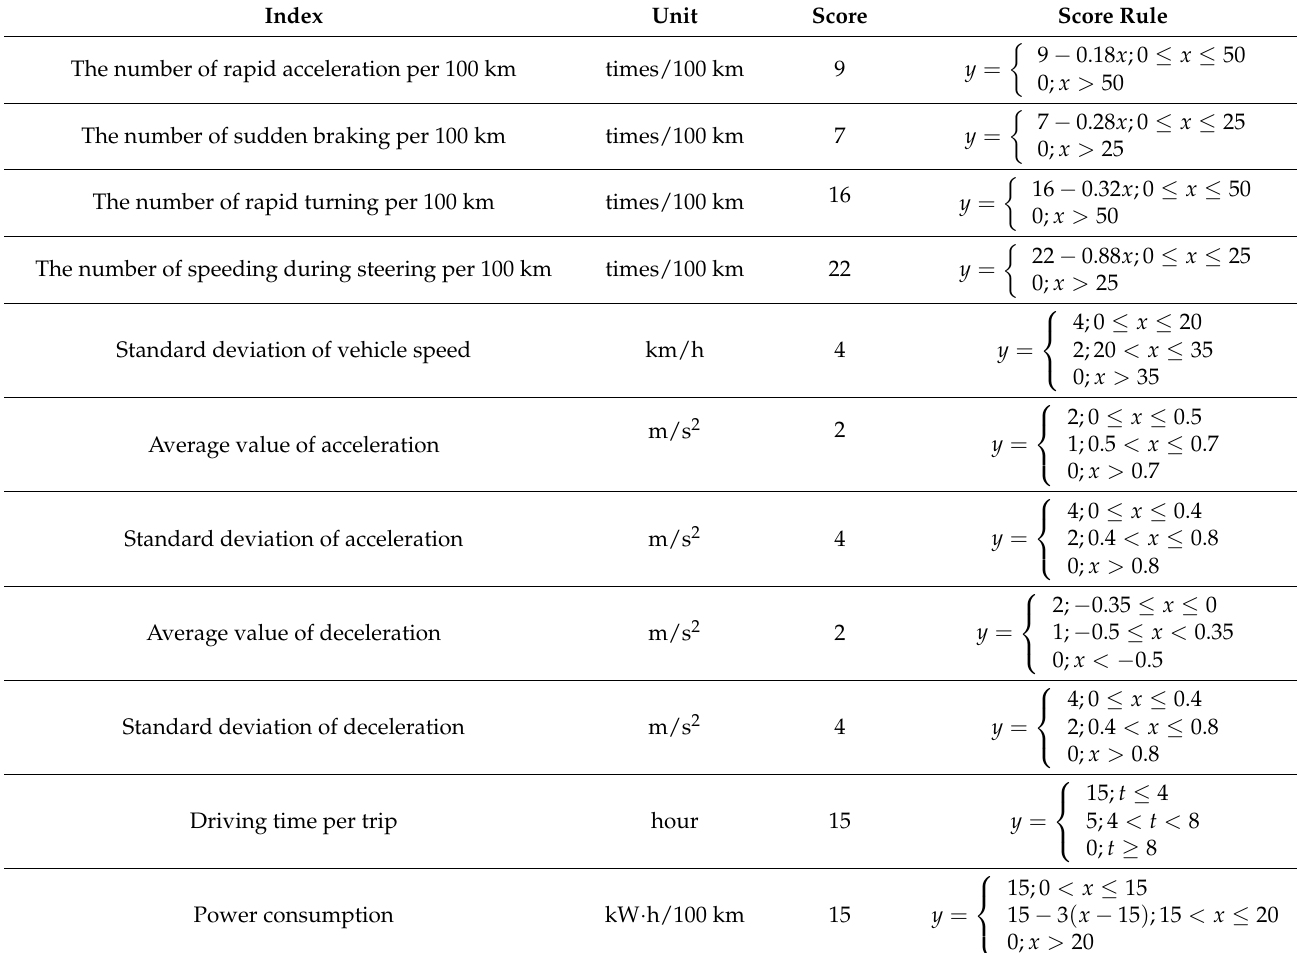
Table 9. The scoring rule of different